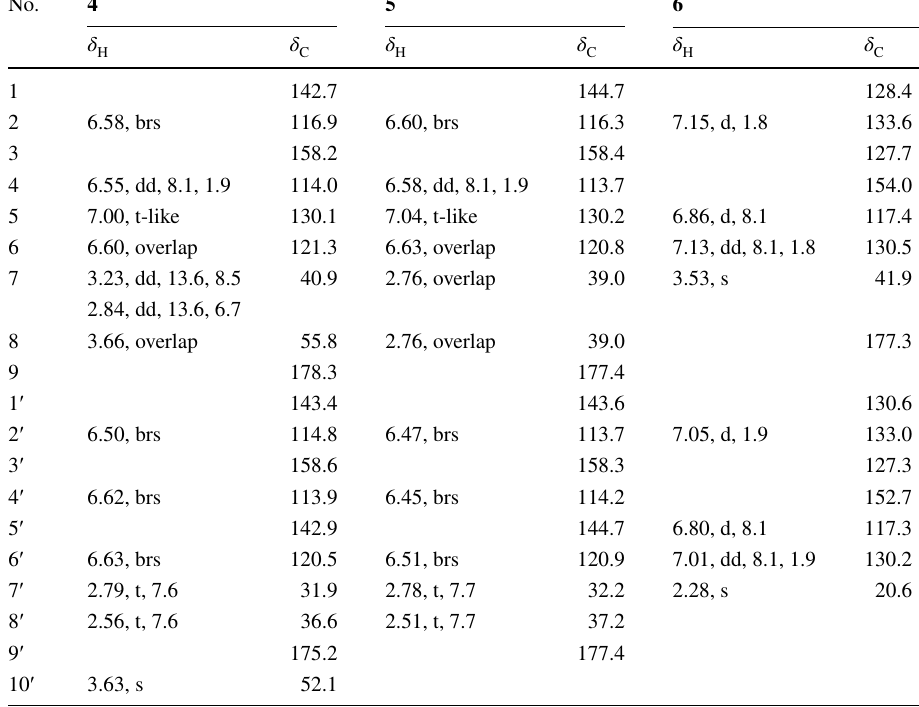
Table 2 1 H (600 MHz) and 13 C NMR (150 MHz) data of 4 – 6 (